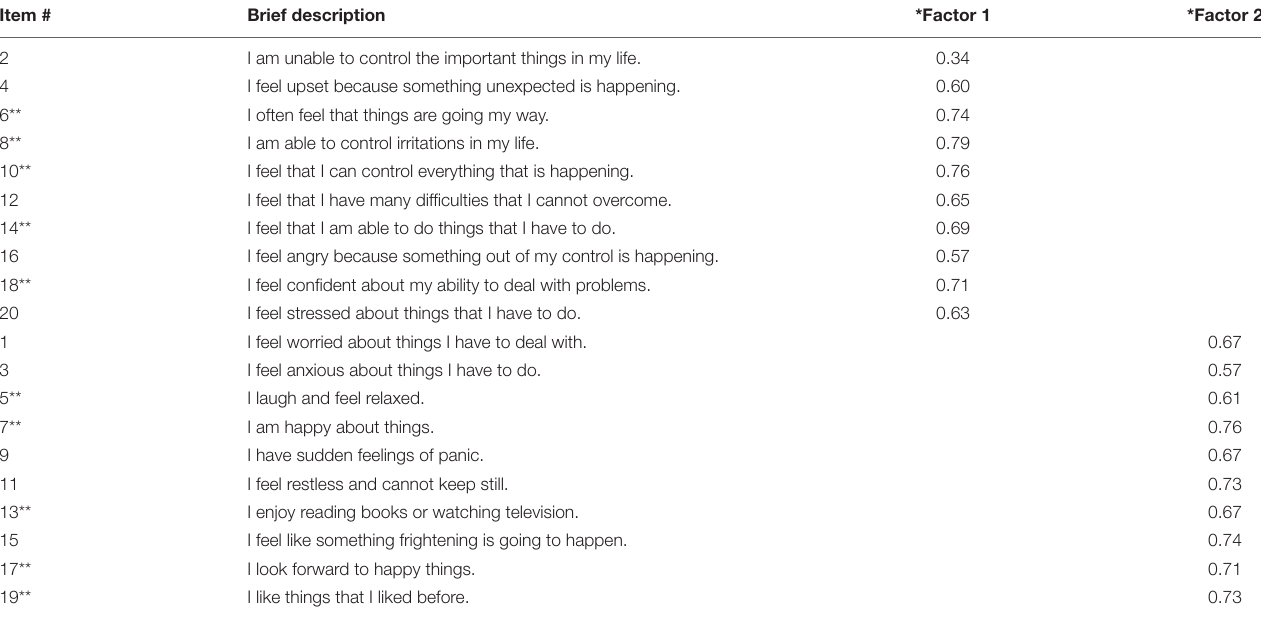
TABLE 1 | A description of the 20 items with factor loadings.